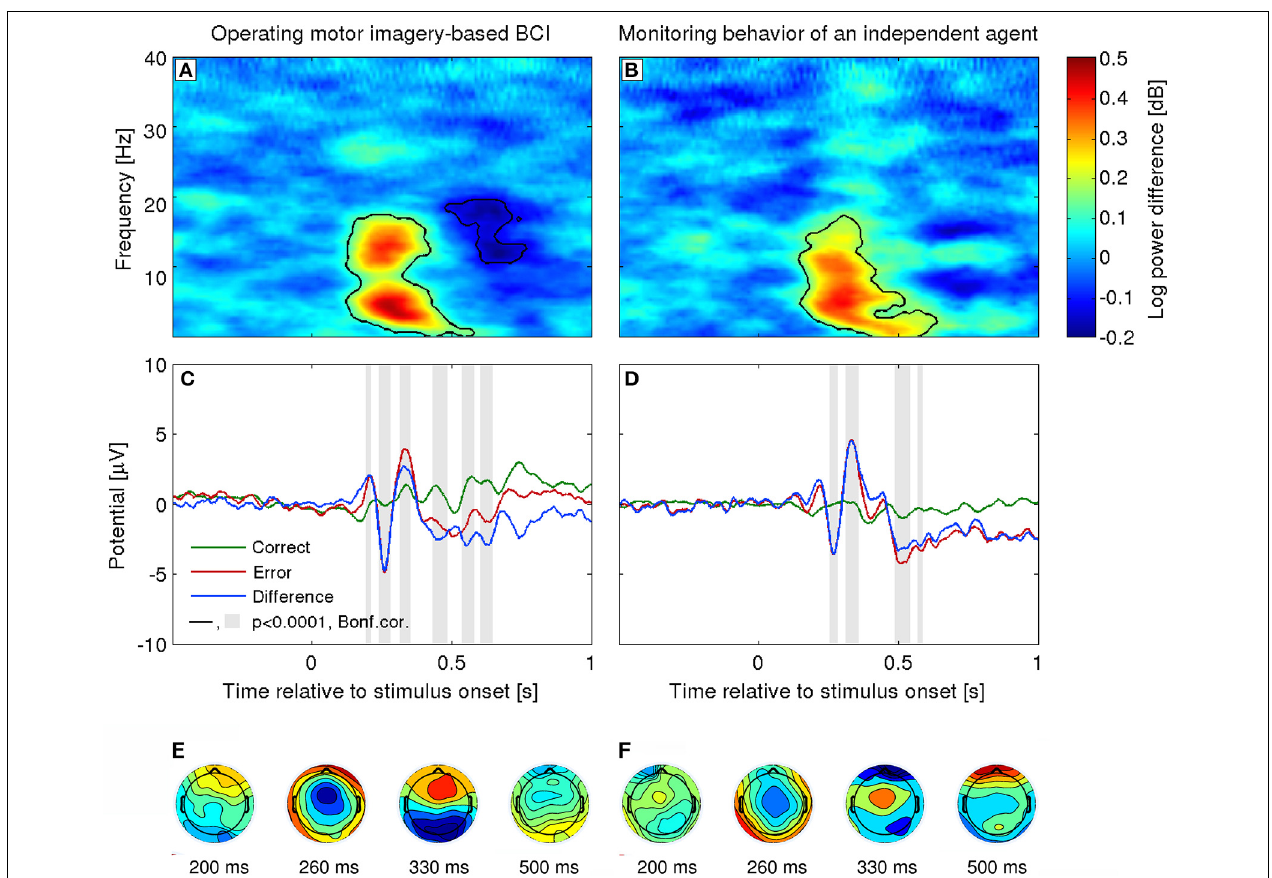
FIGURE 2 | Error-related potentials in a 2-class task used in BMI. Left column, Interaction ErrP. The cursor movement is controlled by a MI-based BMI (Ferrez and Millán, 2008a). Right column, Monitoring ErrP: The cursor moves automatically and the user is asked to evaluate whether it moves toward the target location (Chavarriaga and Millán, 2010). (A,B) Event-related spectral perturbation. (C,D) Grand-average ERP